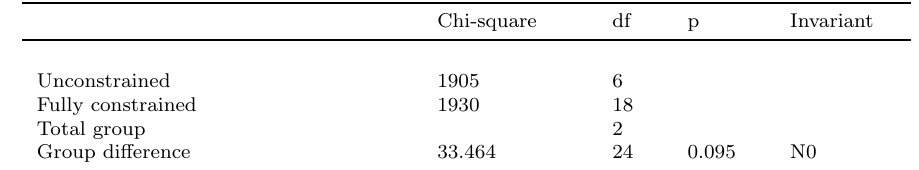
Table 6: Metric invariance analysis